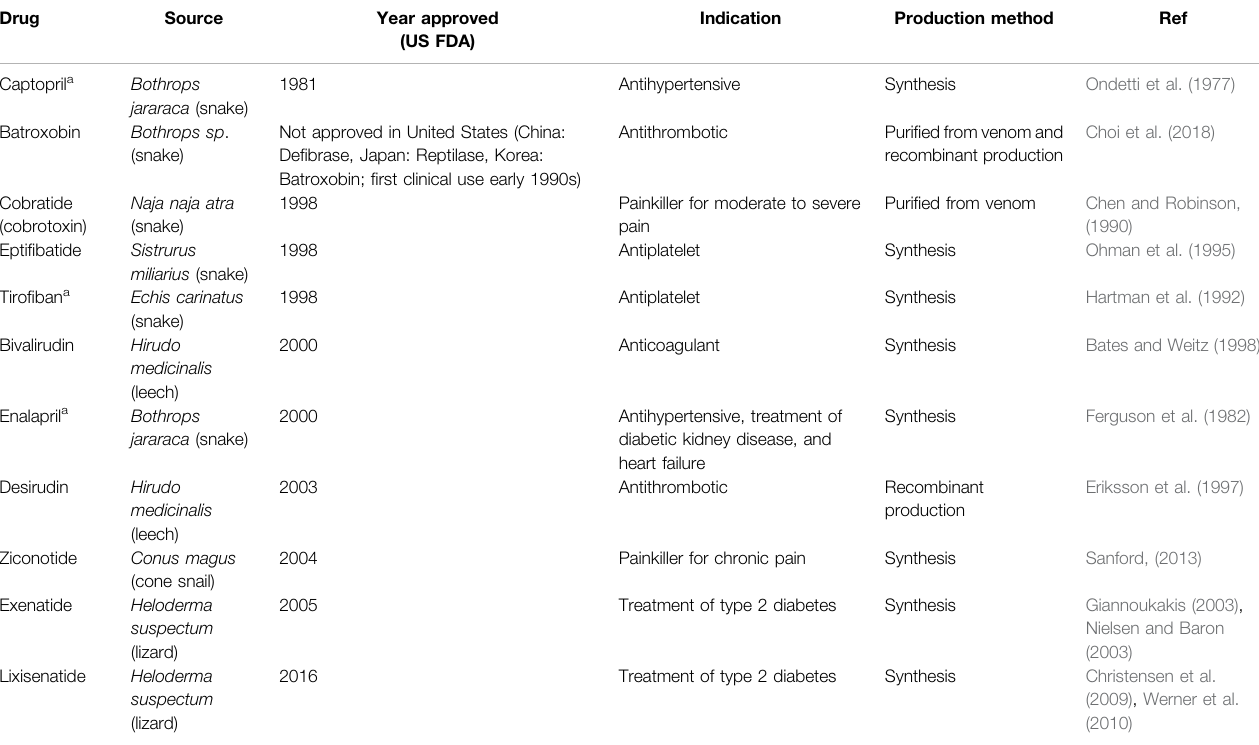
TABLE 2 | Examples of approved toxin-derived drugs (Bordon et al., 2020; Herzig et al.,